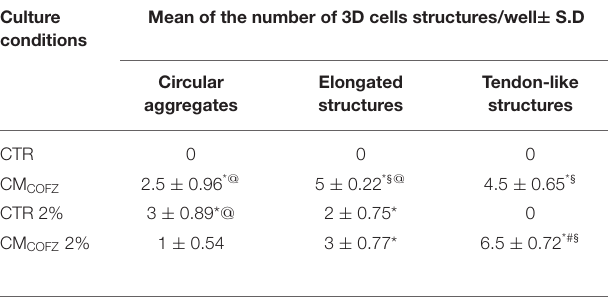
TABLE 5 | Physoxia recovers CM COFZ teno-inductive